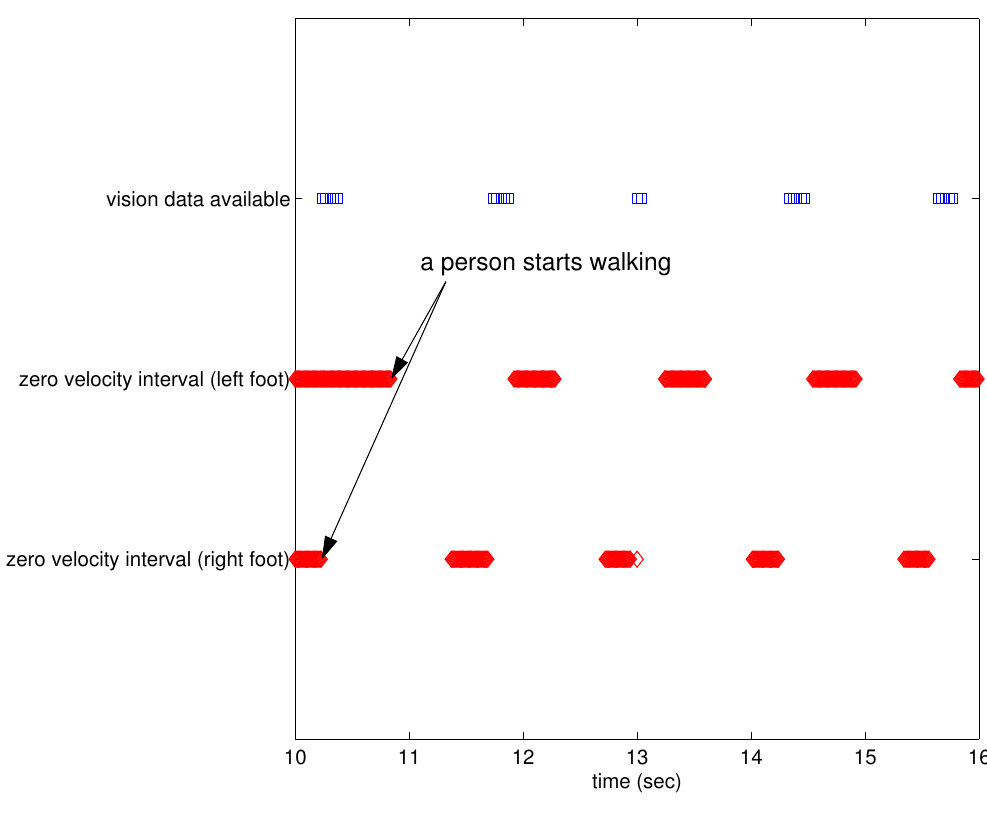
Figure 7. Zero velocity intervals and vision data available